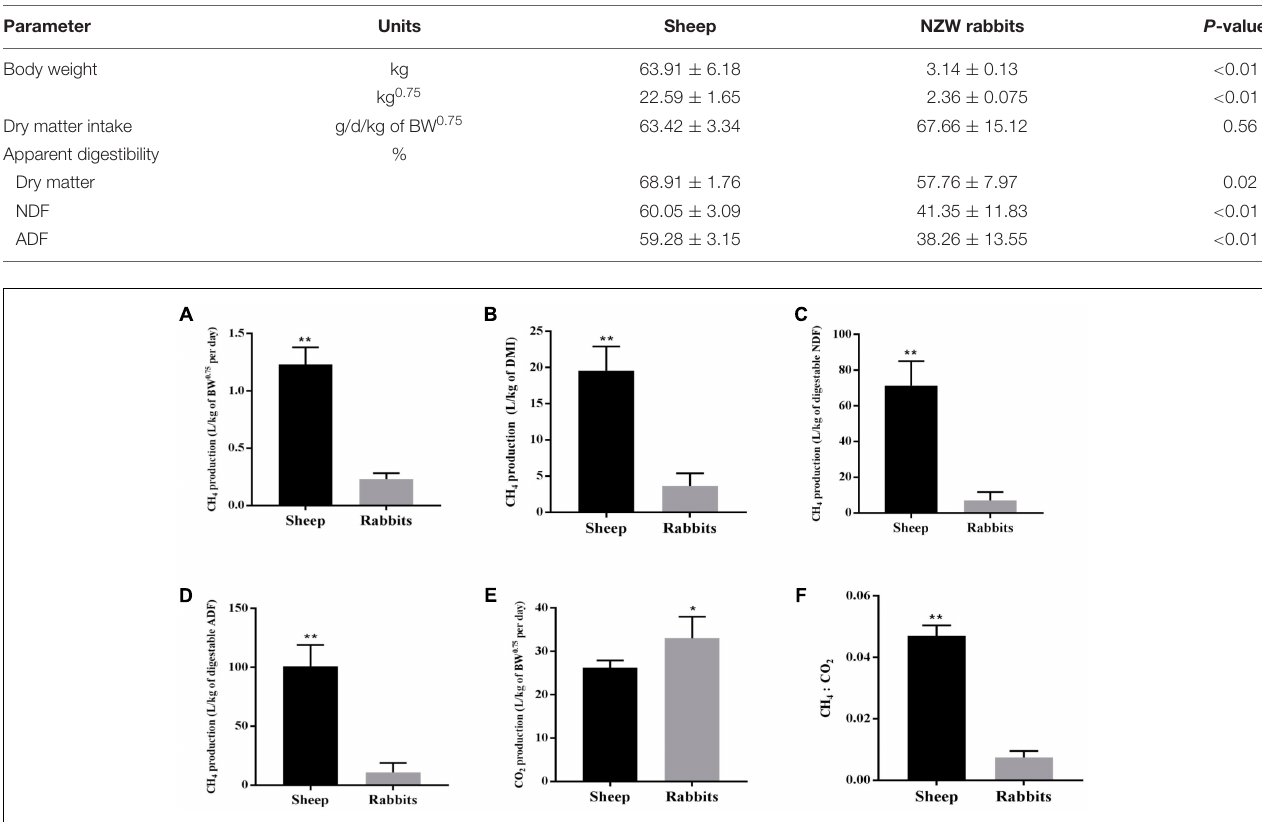
TABLE 1 | Body weight, feed dry matter intake, and digestibility of the sheep ( n = 5) and the rabbits ( n = 15). Parameter